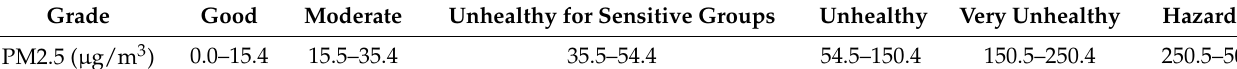
Figure 15, the bar is the standard deviation (STD) of our results in each grade. PM2.5 in data are within 150, so there are no data in grade “Very Unhealthy”. This shows that our results are within the acceptable error in each grade. Table 2. Grade of PM2.5 from Environmental Protection Administration Executive Yuan (R.O.C.).